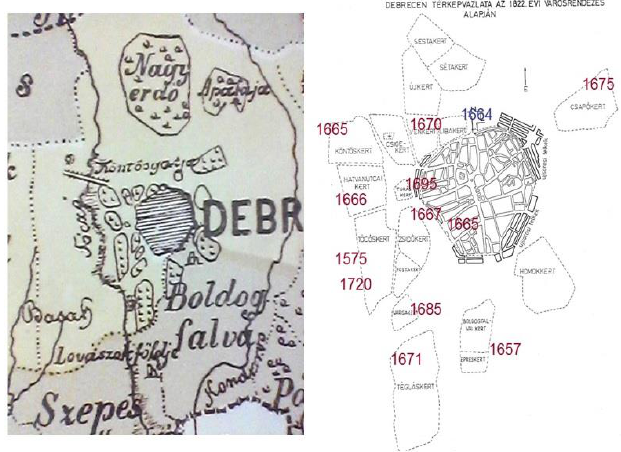
Figure 3. Gardens and vineyards of Debrecen 1650-1680; and in 1822 according to arrangement-plans of the city (HNA-AHBC; Rácz,